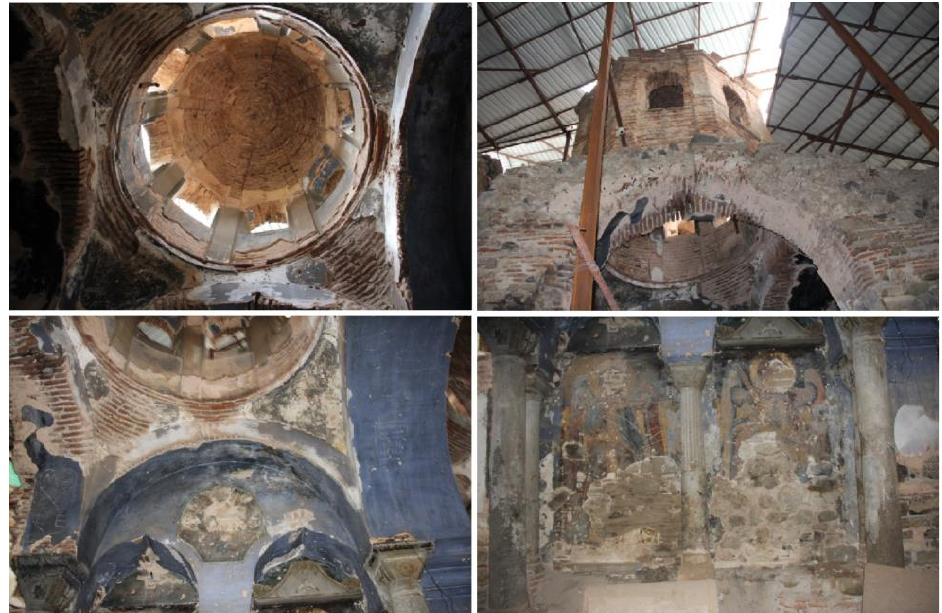
Figure 6. Views of domes, arches and pendentives at narthex.